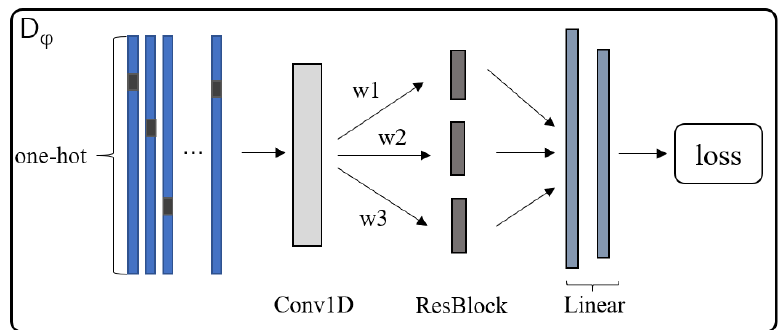
Figure 2. The proposed discriminator framework.